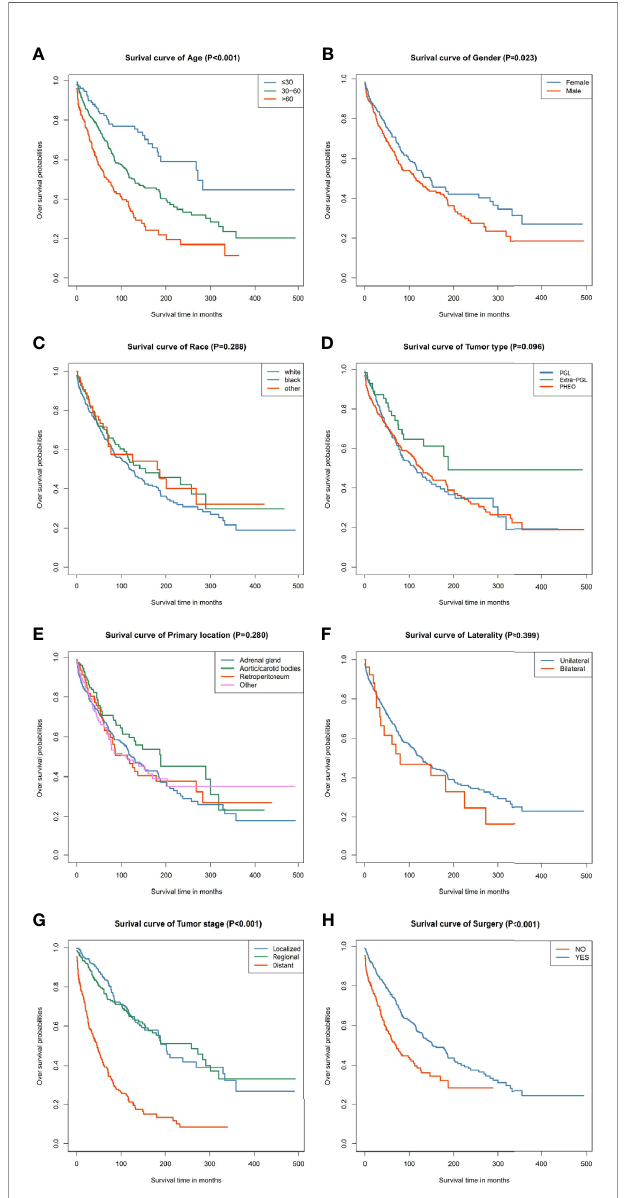
FIGURE 4 | Kaplan – Meier curves of cancer-speci fi c survival for patients based on: (A) age; (B) gender; (C) race; (D) tumor type; (E) primary location; (F) laterality; (G) tumor stage; (H)